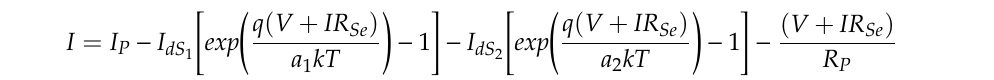
Figure 2. Equivalent circuit of the double-diode model.